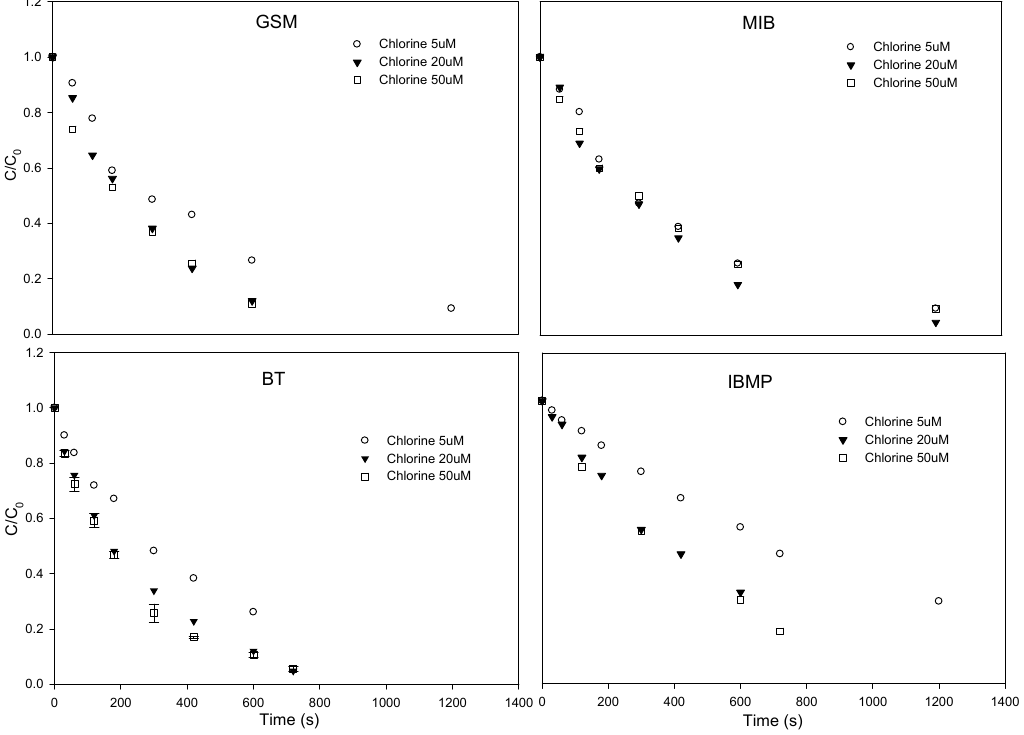
Figure 3. Degradation of GSM, MIB, BT, and IBMP in pure water through the UV/chlorine process at different chlorine concentrations. Conditions: pH = 6; chlorine concentration = 5, 20, and 50 μ M; GSM and MIB concentration = 400 nM; BT and IBMP concentration = 1 μ M; UV intensity = 0.69 μ Einstein L − 1 s − 1 .